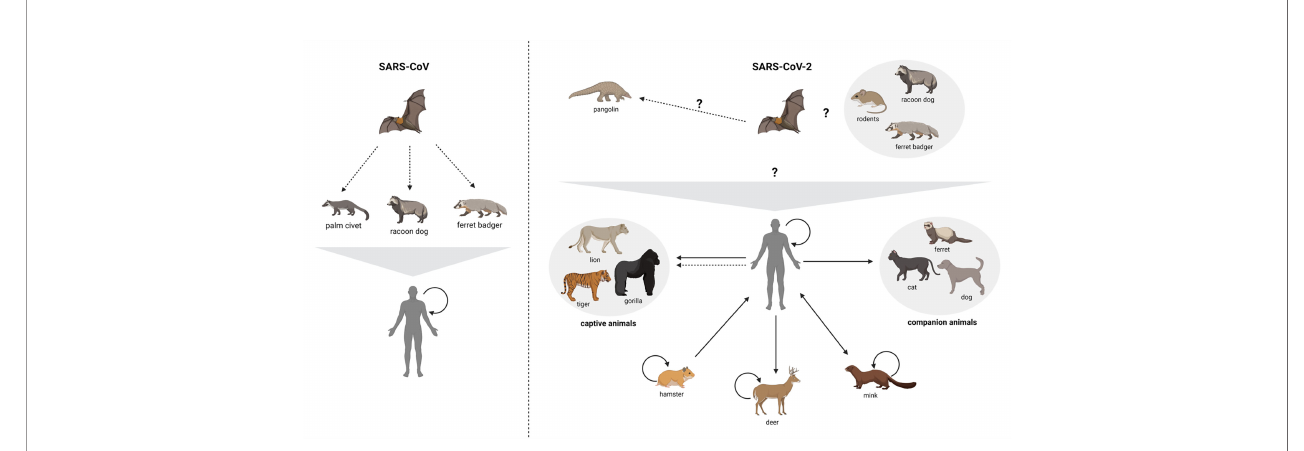
FIGURE 3 | Zoonotic circulation of SARS-CoV and SARS-CoV-2. Suspected and con fi rmed zoonotic circulation of both SARS-CoV and SARS-CoV-2 are presented. Suspected routes of transmission are presented by dashed arrows. Question marks designate routes that have yet to be demonstrated by direct or indirect methods (though are theorized or probable). Note that there is epidemiological and genetic evidence for some human-to-captive animal transmission events (179, 180) while others are suspected/probable. Solid lines represent con fi rmed transmission events. Created with